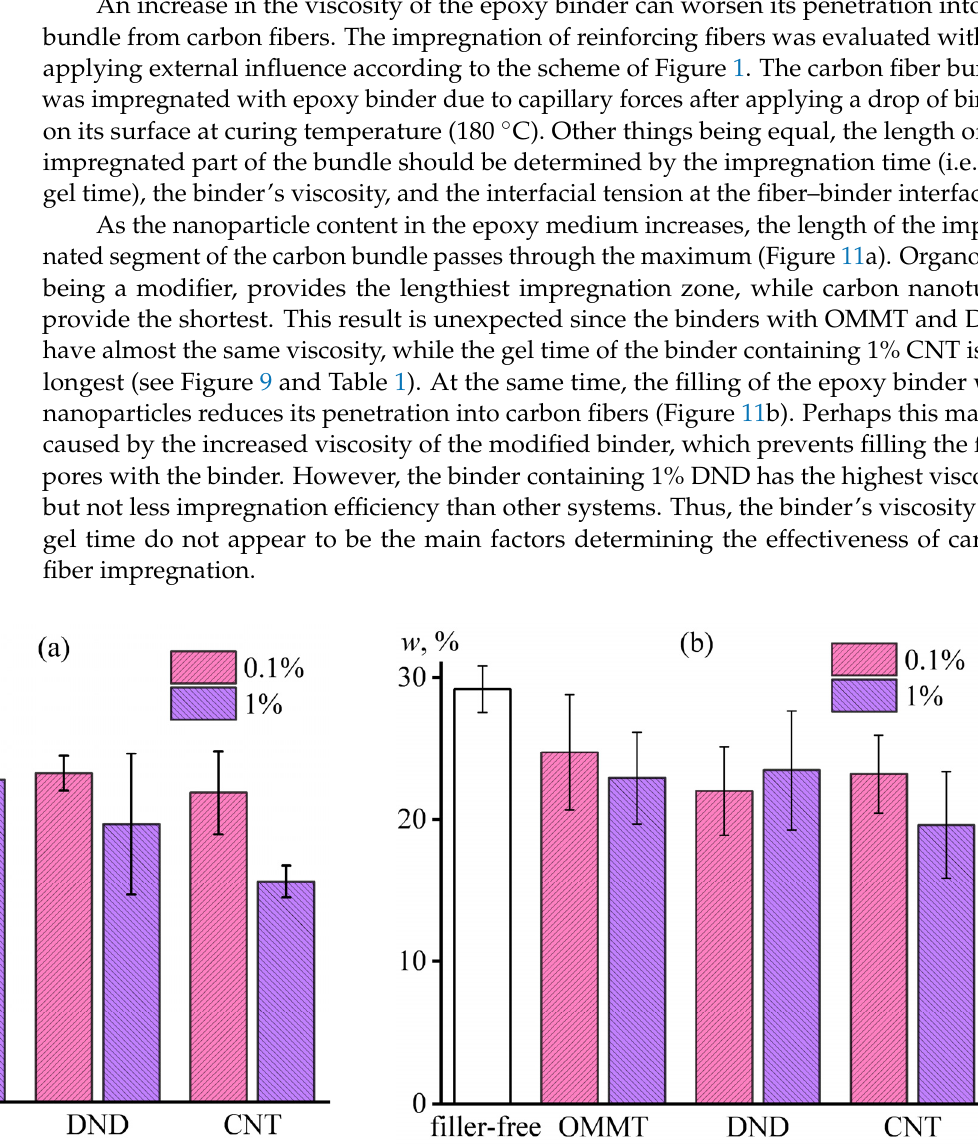
Figure 11. Effect of nanoparticles on the length of the impregnated part of the carbon fiber bundle ( a ) and the mass fraction of the binder in this part ( b ). Legends show the mass fraction of nanoparticles in the epoxy matrix.